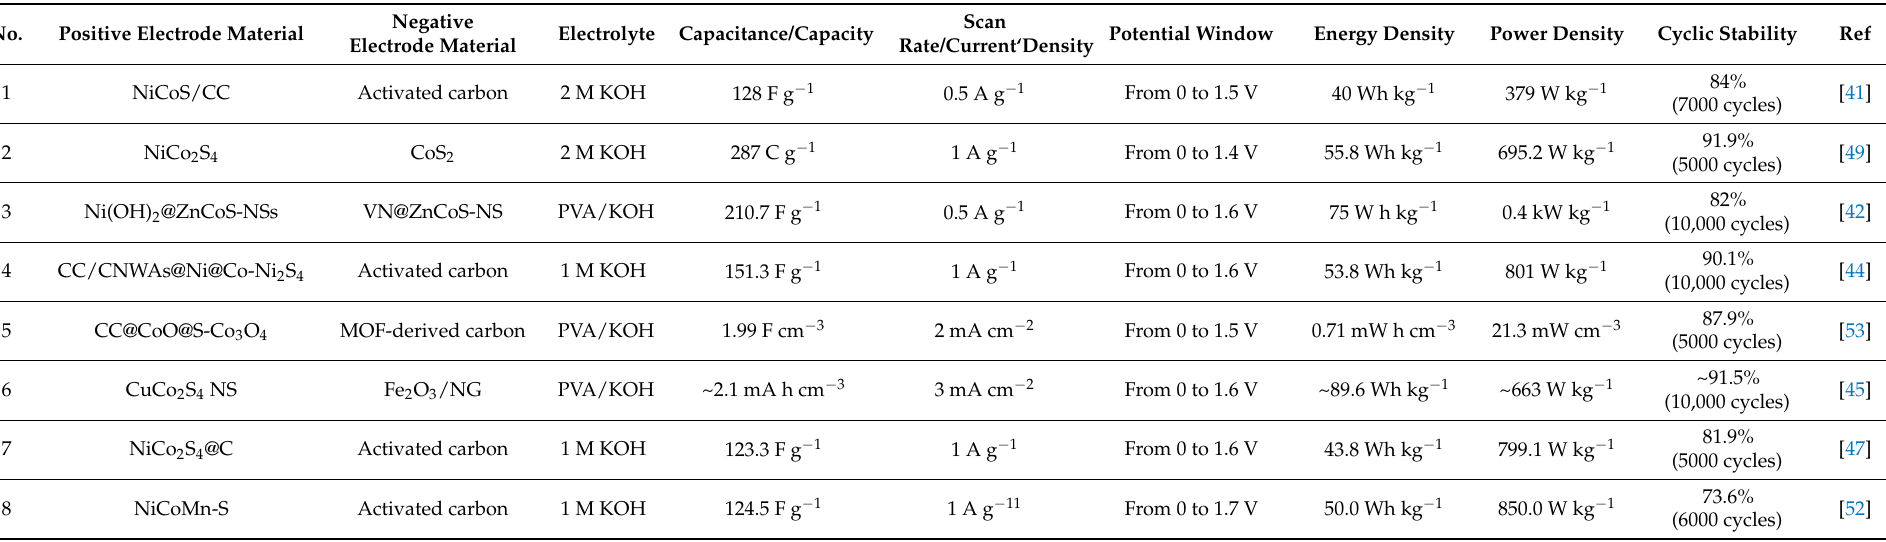
Table 2. Summary of the electrochemical parameters of the sulfurized MOF-based electrodes in two-electrode measurements